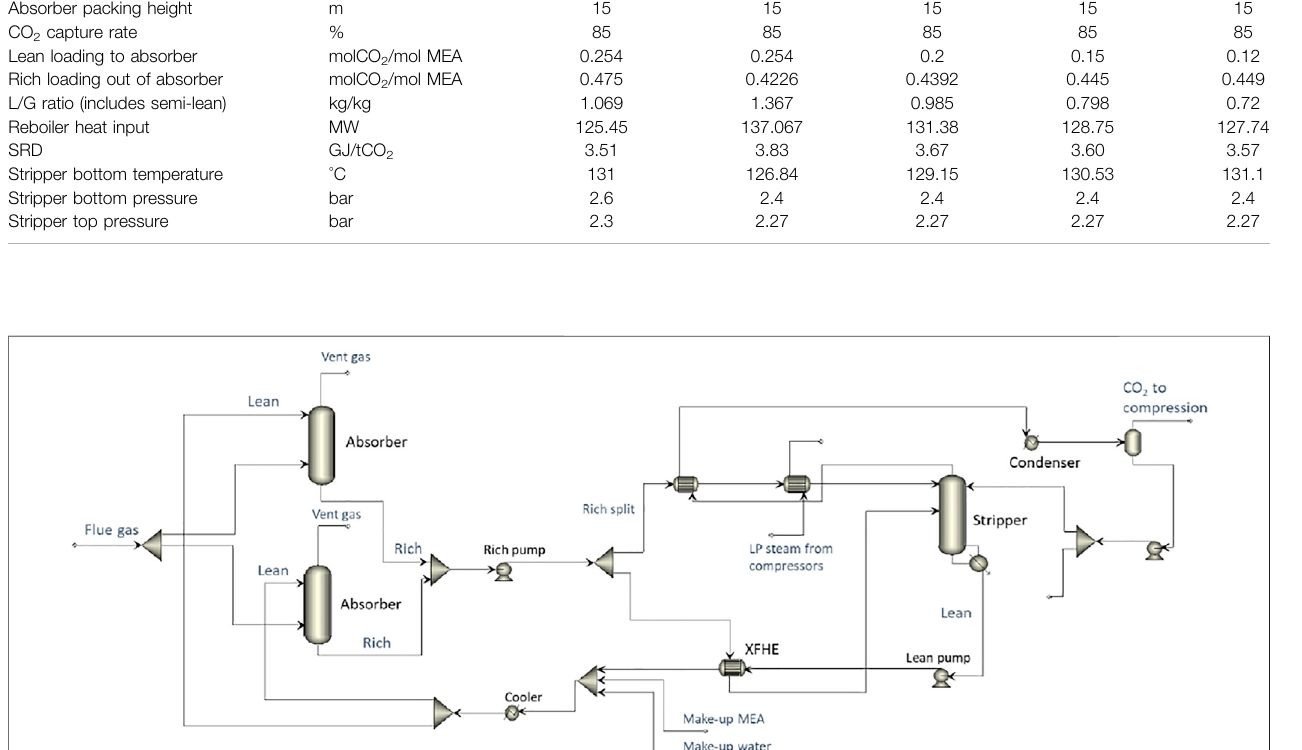
TABLE 3 | Comparison of predicted SRD* values for Sherman con fi guration. Parameter